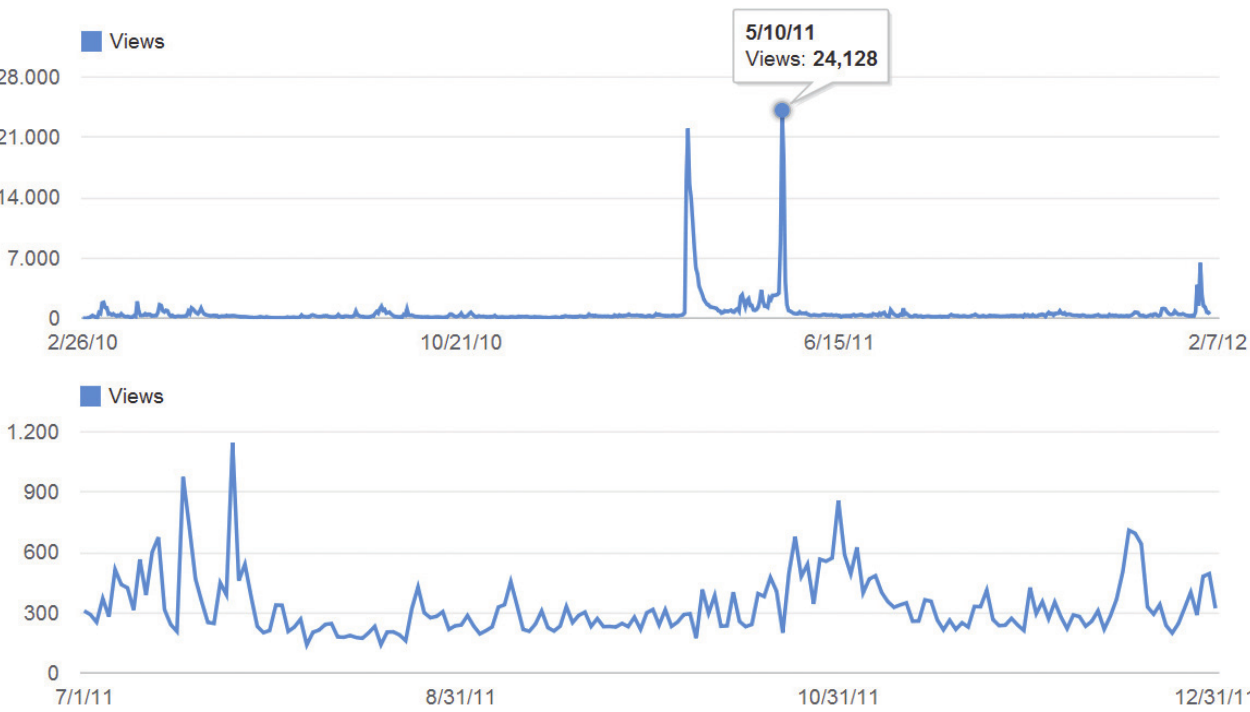
Figure 1. Top: History of daily INGV YouTube channel views from February 2010 to the beginning of February 2012. The two main peaks corresponding to the Tohoku, Japan, earthquake on March 11, 2011, and the Rome presumed earthquake prediction on May 11, 2011. The third double peak at the end of January 2012 was due to some moderate shocks felt in northern Italy. Bottom: Detail for the number of INGV YouTube channel views for July- December 2011. Even without strong events, the daily number of views remains relatively high (around 300-400), with some peaks around 1,000.